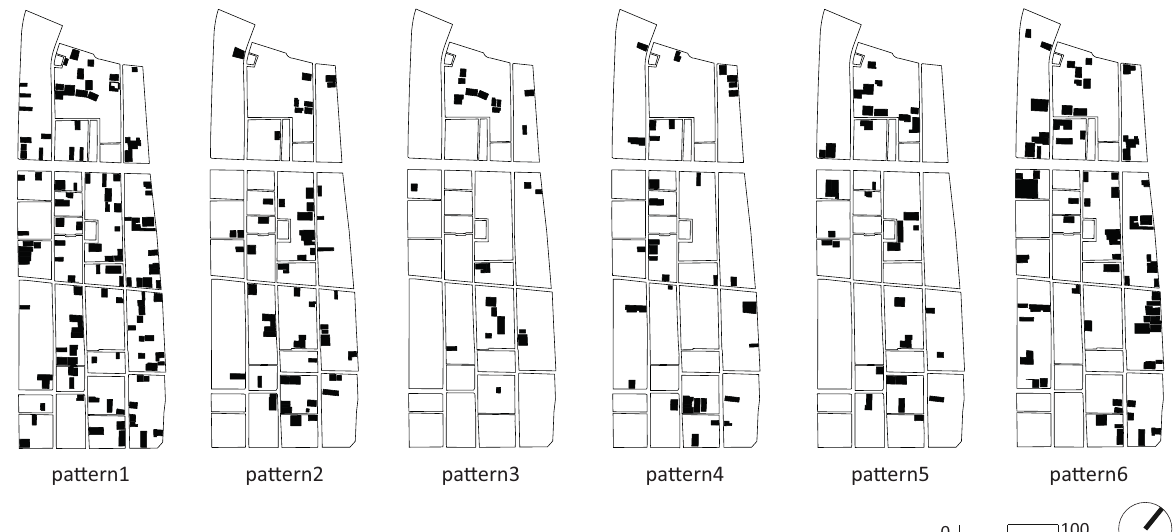
Figure 2. Map identifying change of the public‐private